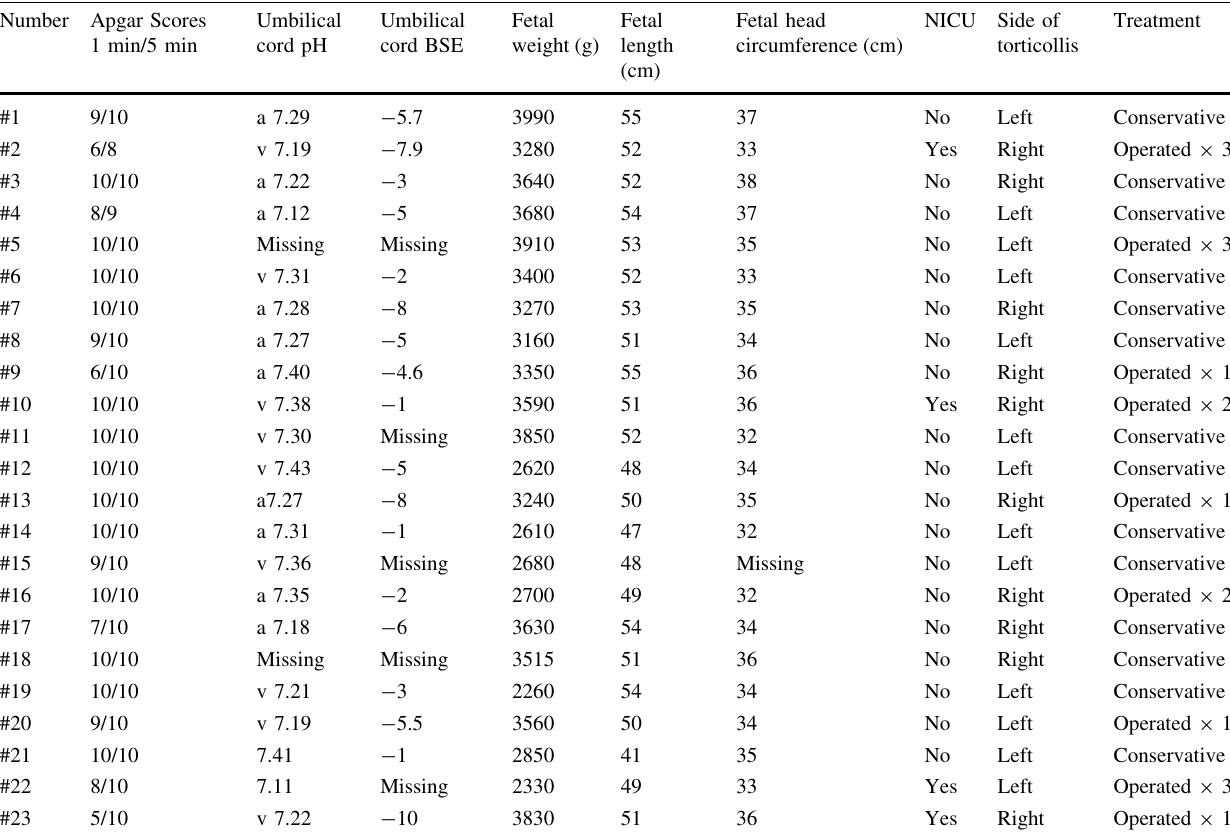
Table 2 Neonatal and treatment outcomes in 23 children with a diagnosis of torticollis born at Aarhus University Hospital from 2000 to 2014 Number Apgar Scores 1 min/5